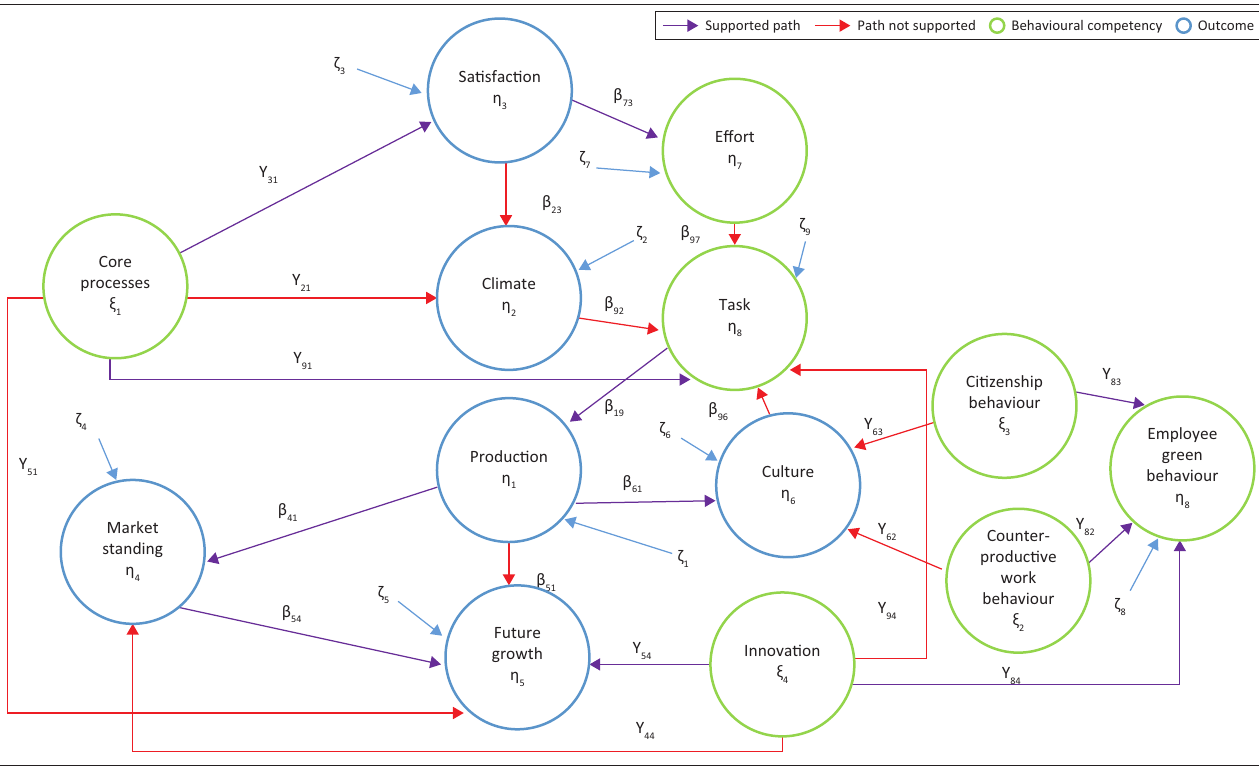
FIGURE 1 : Proposed work unit performance structural